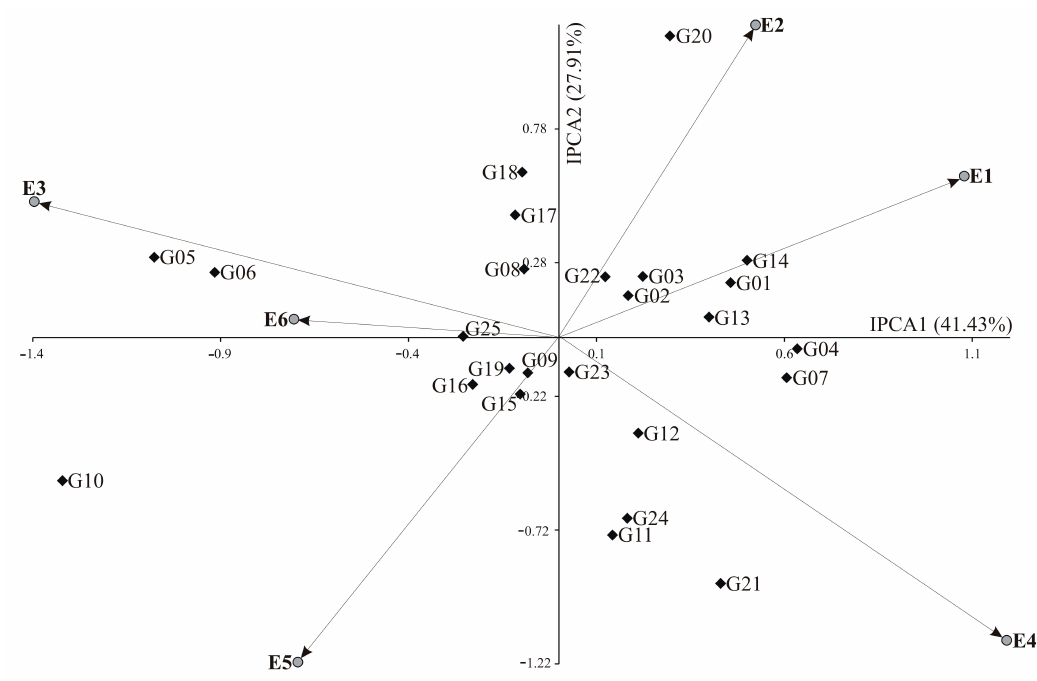
Figure 2. Biplot for genotype by environment interaction of oil content in 25 winter oilseed rape ( B. Figure2. Biplotforgenotypebyenvironmentinteractionofoilcontentin25winteroilseedrape( B.napus